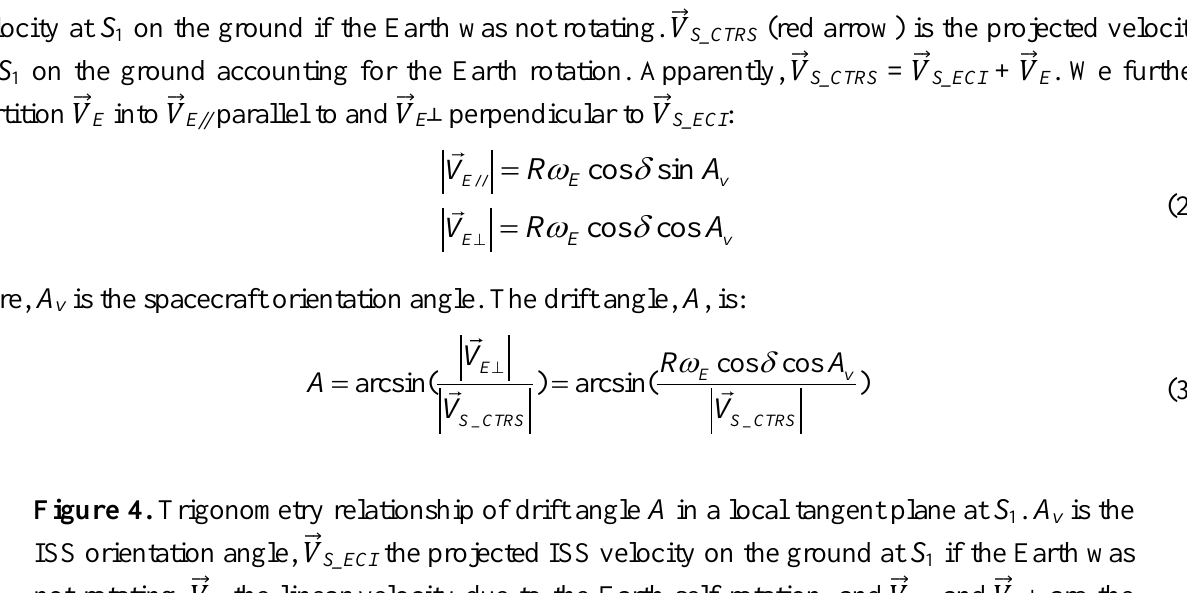
. A is the 1 v if the Earth was 1 and are the E// E┴ is the projected S_CTRS